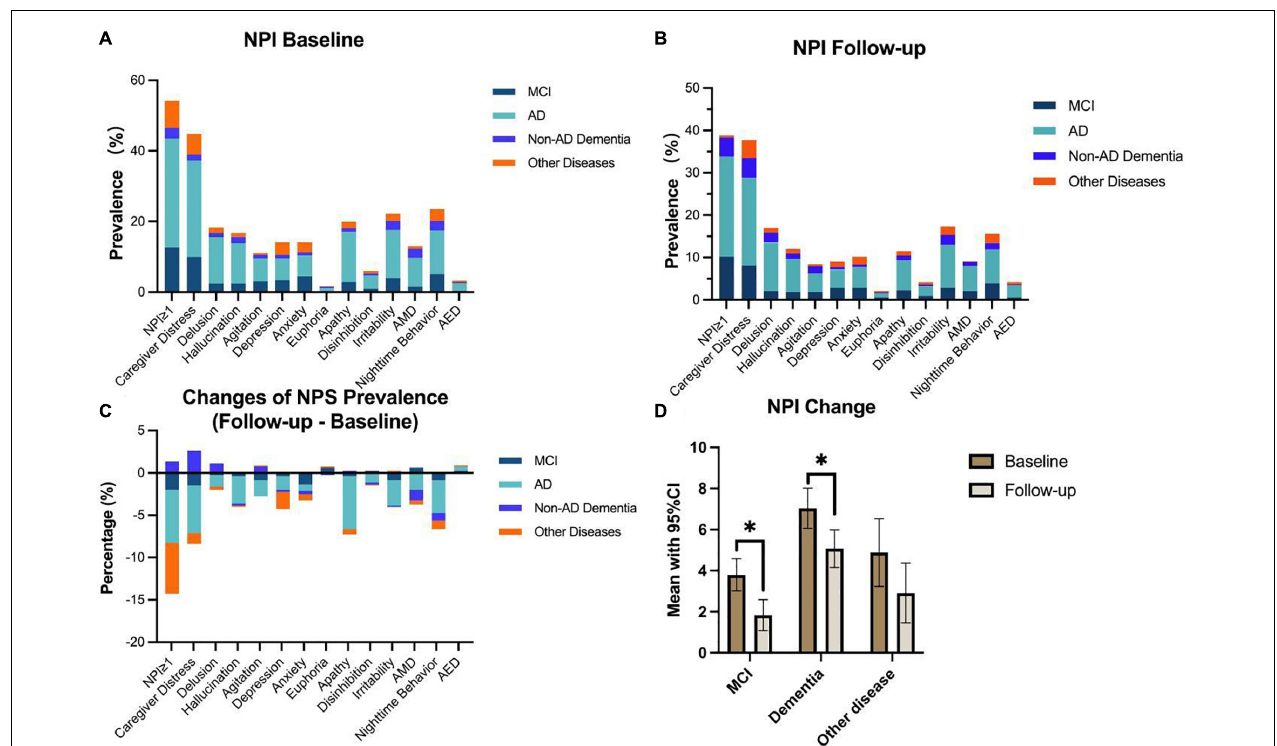
FIGURE 2 | Neuropsychiatric inventory (NPI) changes among each neuropsychiatric symptom (NPS) subdomain and diagnostic group. Nearly, 55% of participants had at least one type of NPS at baseline, and this rate dropped to lower than 40% at follow-up (A,B) . The most prevalent NPS were nighttime behavior (23.54%), irritability (22.22%), and apathy (19.95%) at baseline (A) , while at follow-up, this ranking changed to irritability (17.32%), delusion (16.95%), and nighttime behavior (15.62%) (B) . As for the changes of NPS prevalence (C) , compared with baseline, nearly all NPS, except for euphoria and AED, showed a downward trend, among which apathy and nighttime behavior were the leading subdomains (dropped by 8.44% and 7.92%, respectively). In generalized estimation equation analysis, patients with MCI and dementia revealed significant alleviation in NPS performance in 8 months after the quarantine (* P < 0.05) (D)